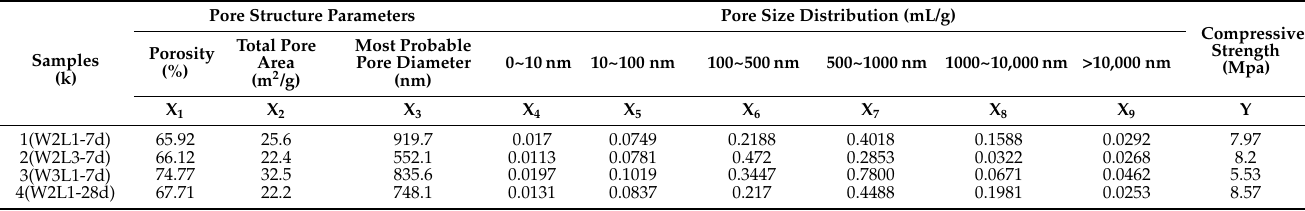
Table 5. The various parameters of sequence X and Y.